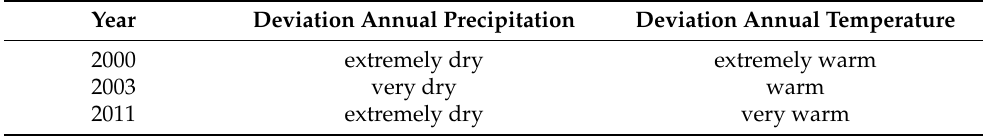
Table 1. Deviation of annual precipitation and air temperature in 2000, 2003, and 2011.